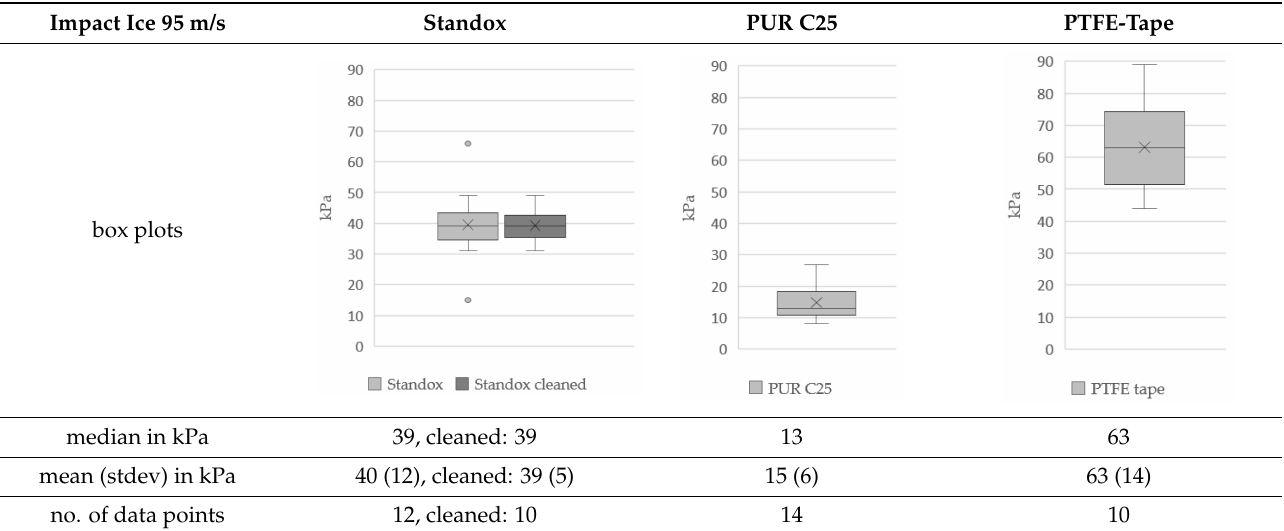
Table 5. Ice adhesion centrifuge test results for impact ice (95 m/s; acceleration speed 200 rpm/s) with relevant statistical data for result evaluation (given “cleaned” values based on outlier replacements after box plot assessments).